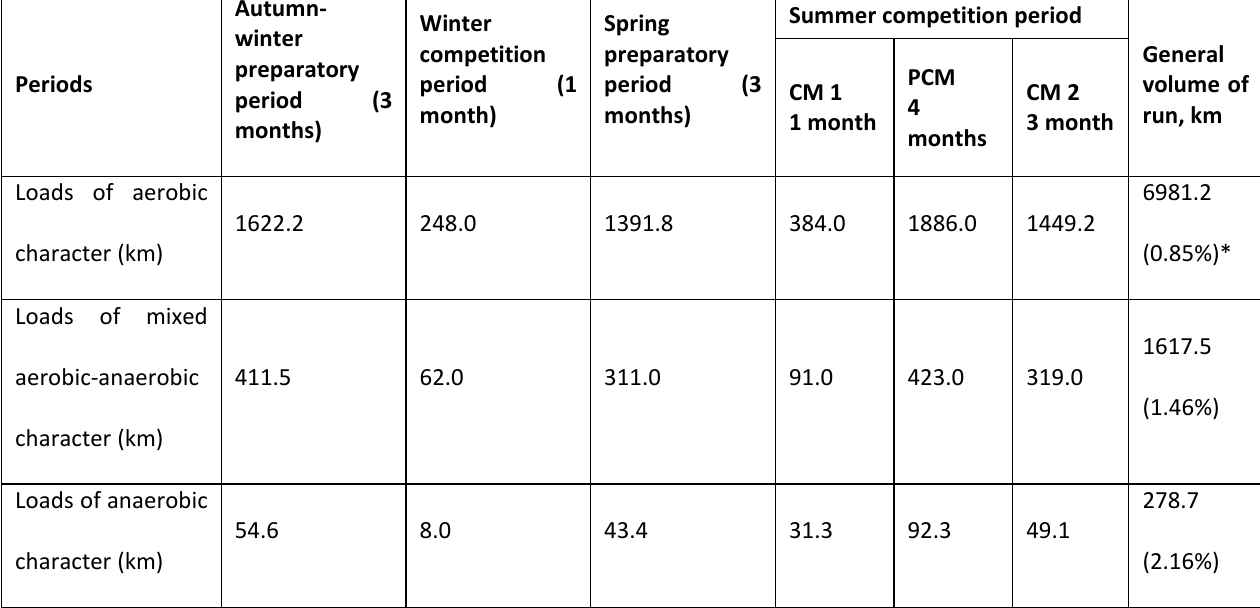
Table 1. Structure of training process’s construction and parameters of differently oriented training loads’ volumes in annual macro